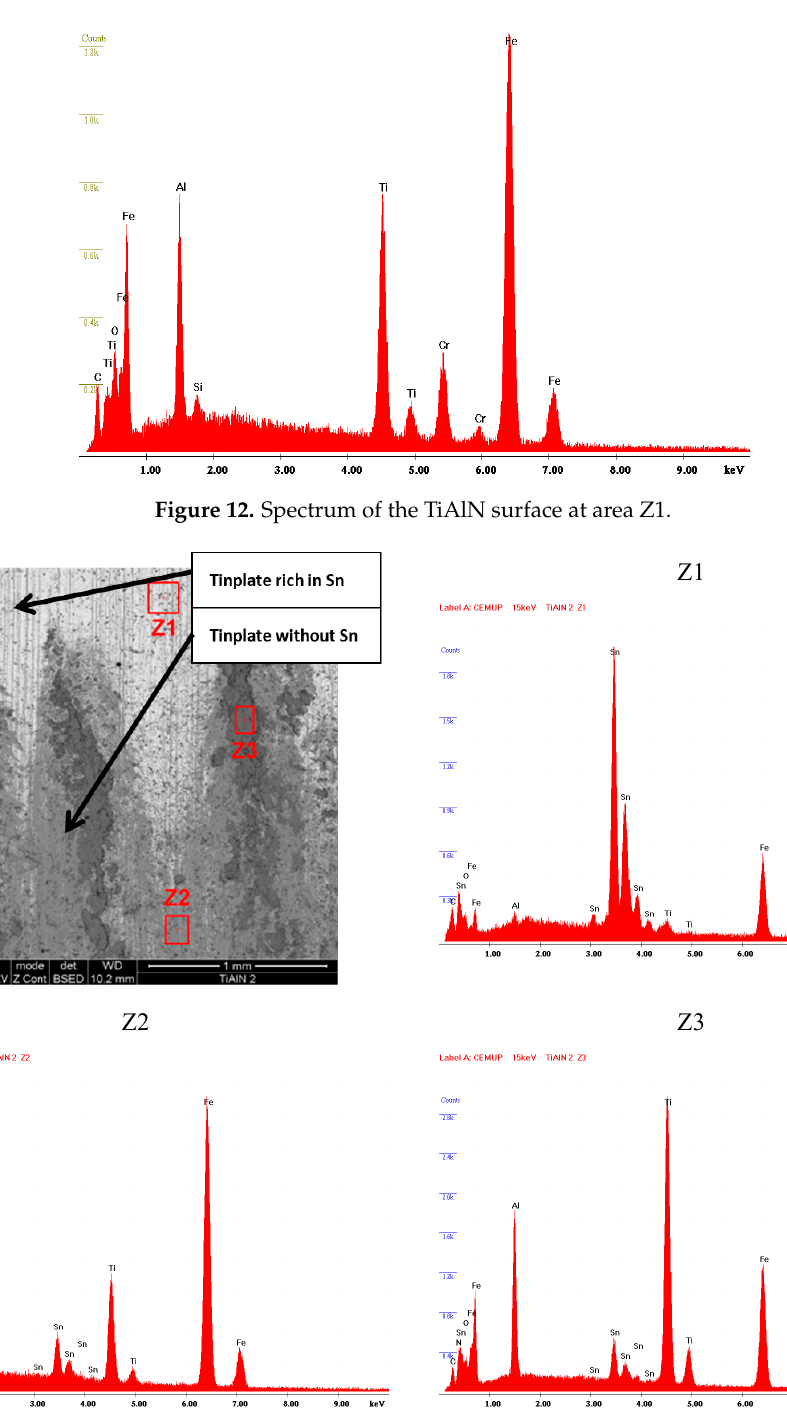
Figure 13. SEM observation and spectra of transferred TiAlN coating particles.